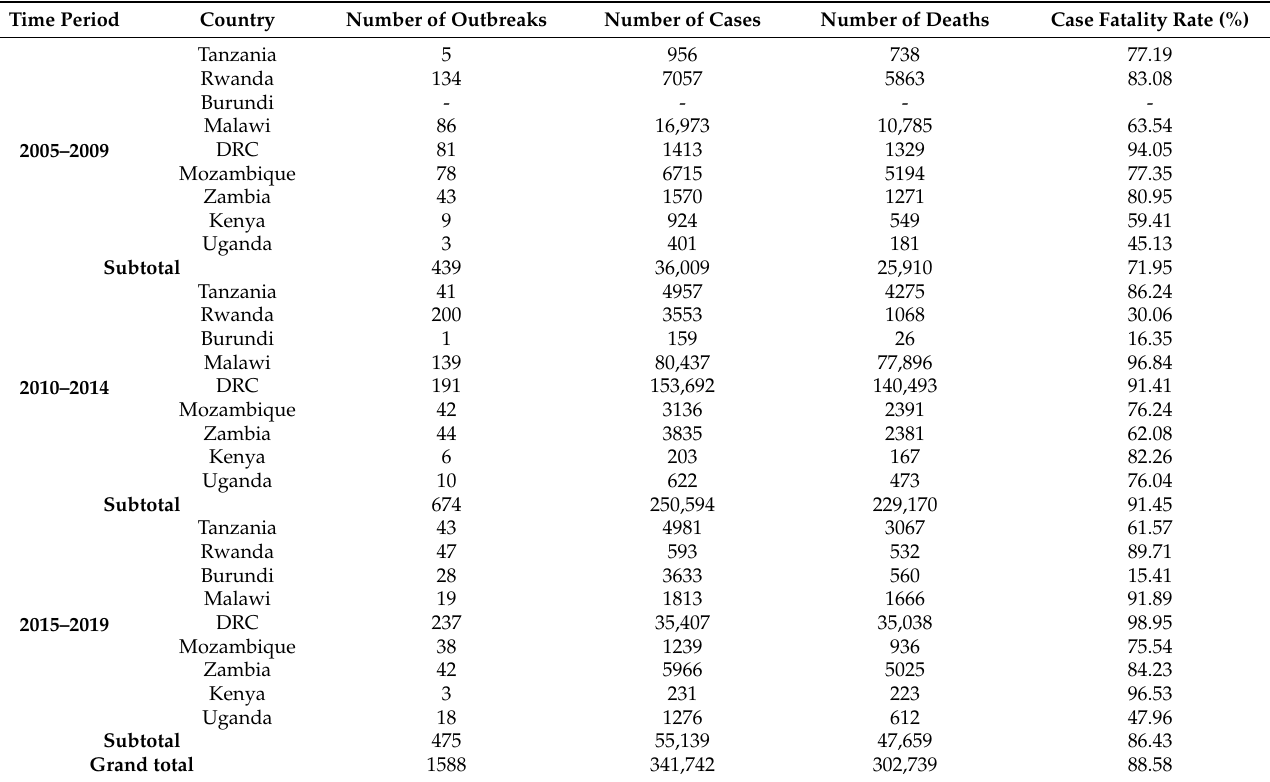
Table 1. African swine fever outbreaks, cases, deaths, and case fatality rate reported to the World Organization for Animal Health (OIE) by Tanzania and its eight neighboring countries from 2005 to 2019.